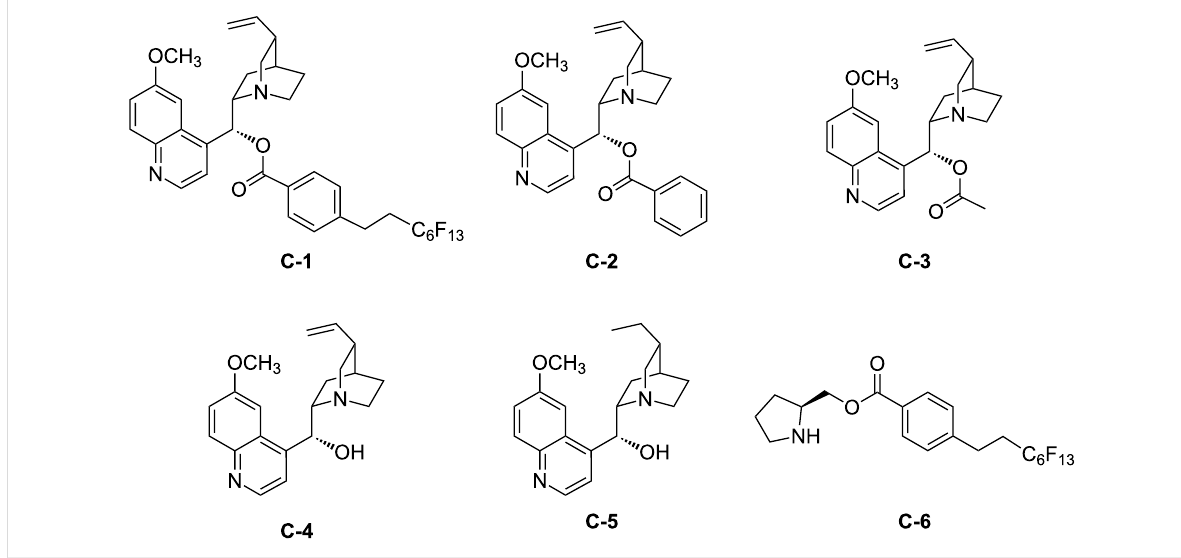
Figure 2: Promoters for asymmetric fluorination.